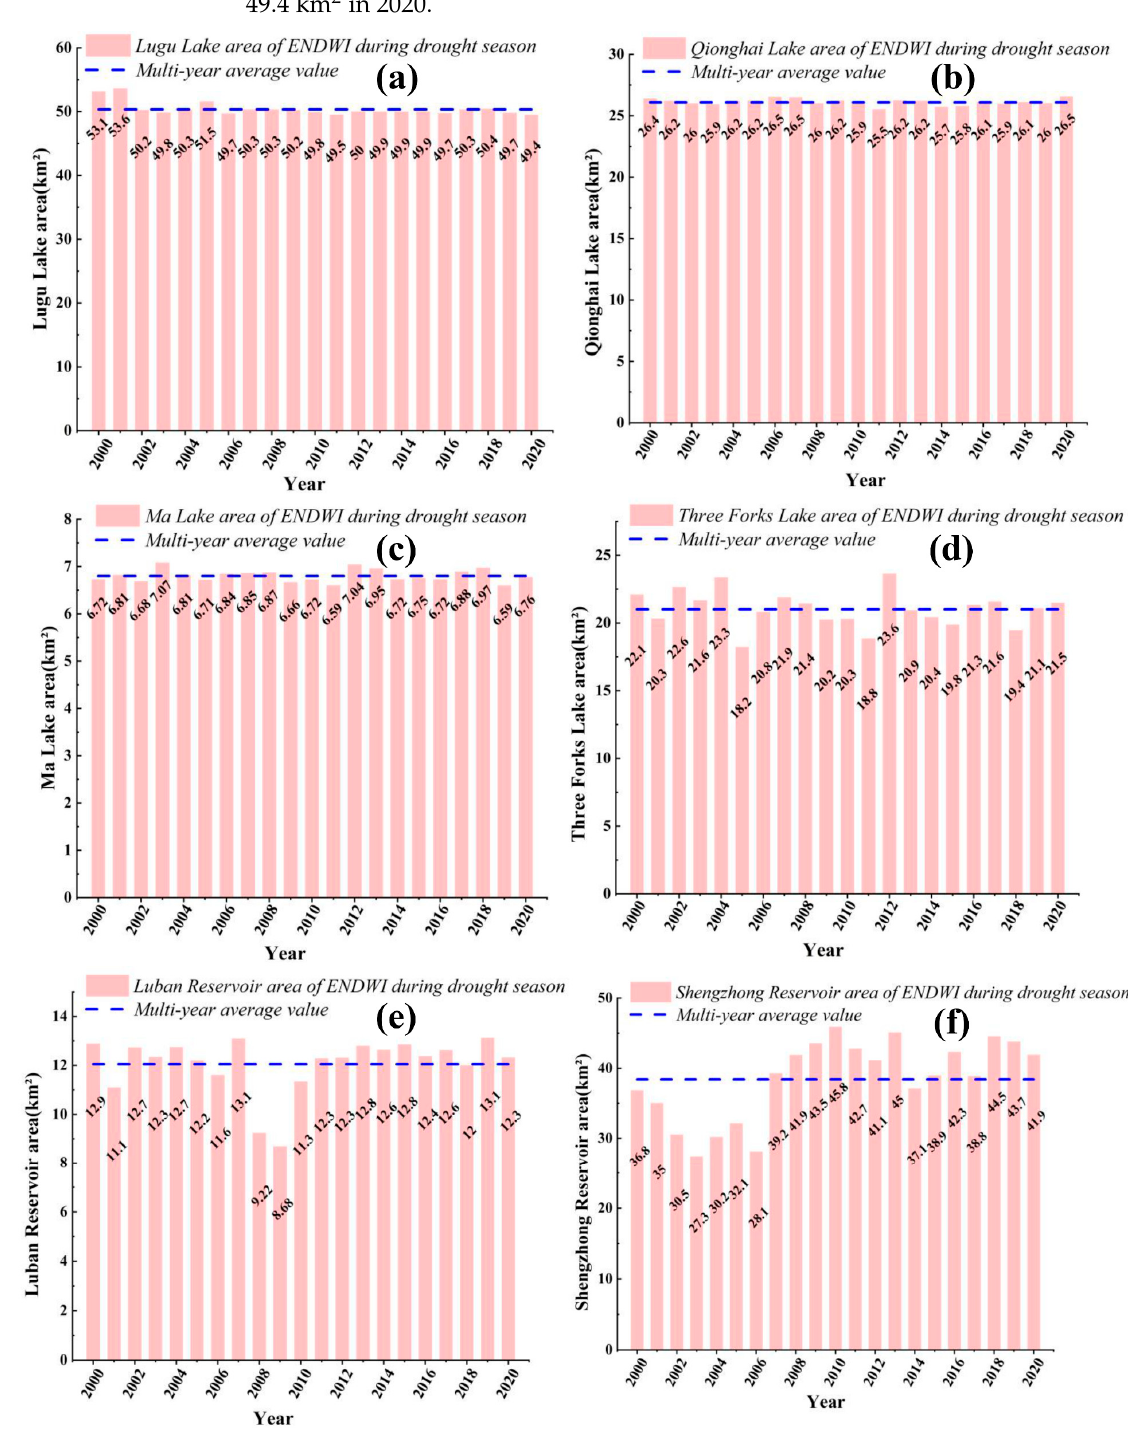
Figure 8. Change in dry season area of selected lakes from 2000 to 2020. ( a ) Lugu Lake; ( b ) Qionghai Lake; ( c ) Ma Lake; ( d ) Three Forks Lake; ( e ) Luban Reservoir; ( f ) Shengzhong Reservoir. Note, the dashed line indicates the multi-year average lake area during the dry season.